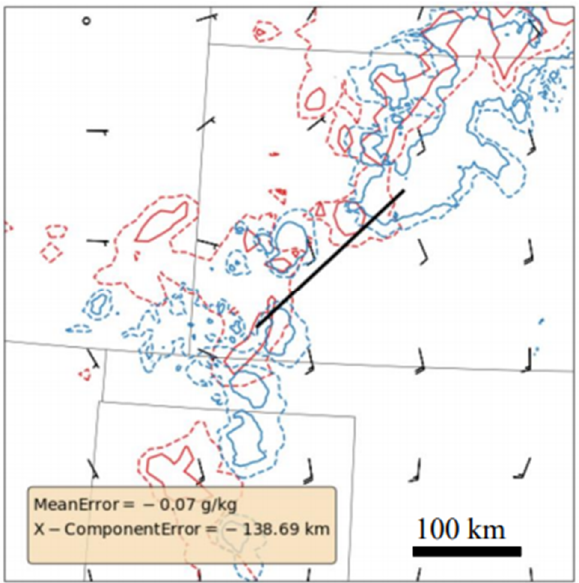
Figure 5. As in Figure 4, but for a Type A case on 15 June 2012 at 0000 UTC and showing the X-component error (km) instead of the Y-component displacement error in the box. Distance scale shown in lower right.